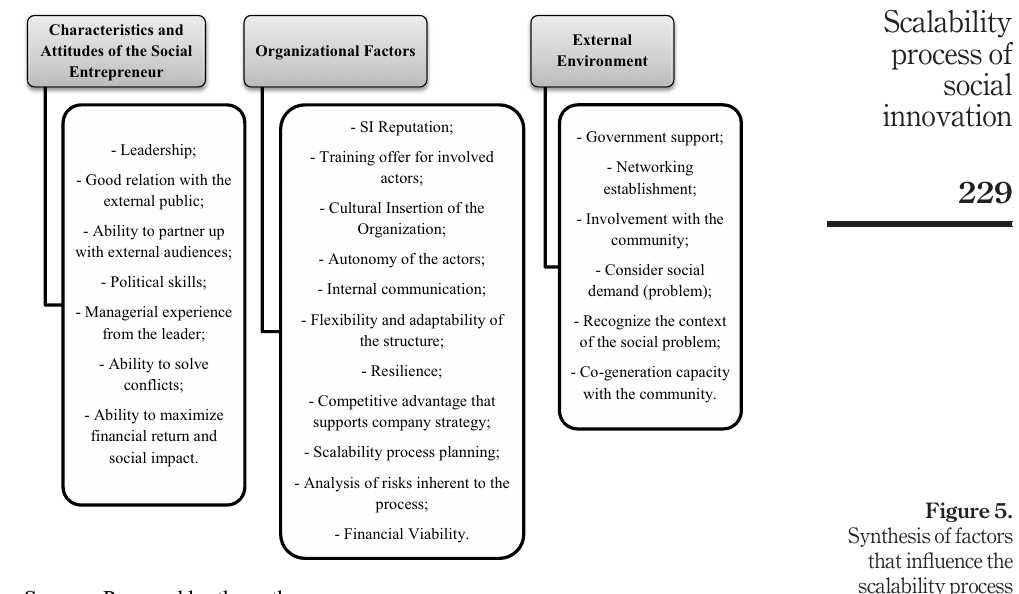
Figure 5. Synthesis of factors that in fl uence the scalability